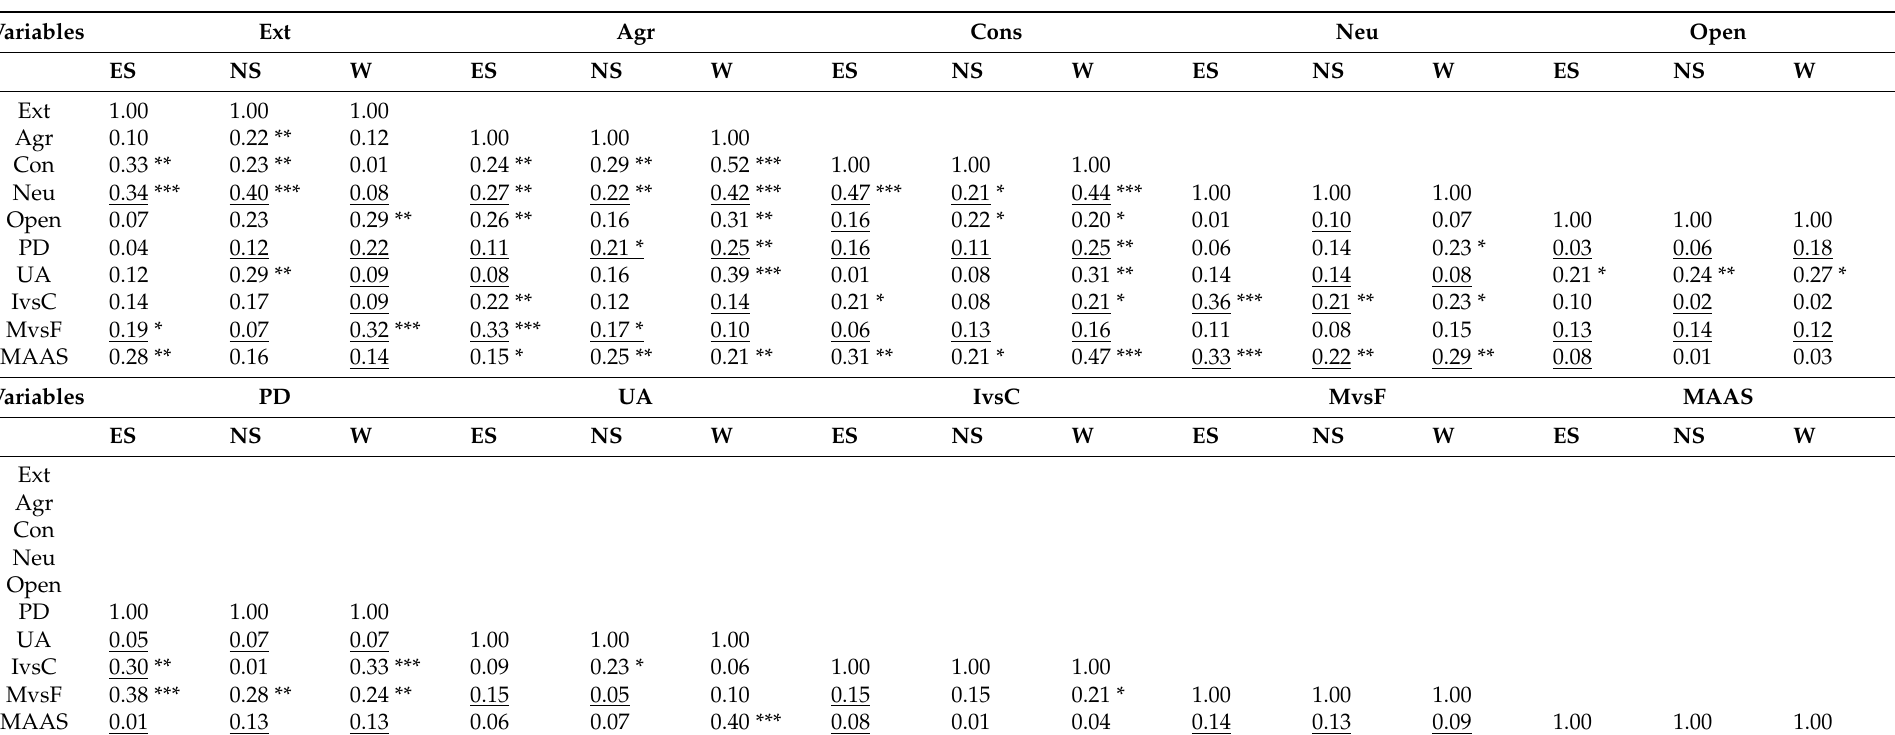
Table 4. Correlation matrix of